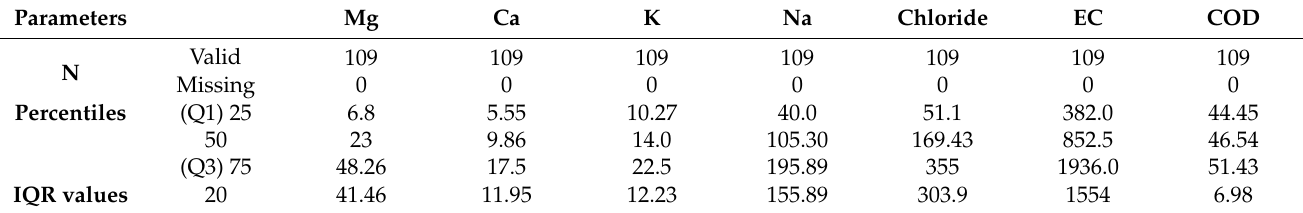
Figure 4. GWQI in graphical features. Table 10. Interquartile range (IQR) calculation for each index